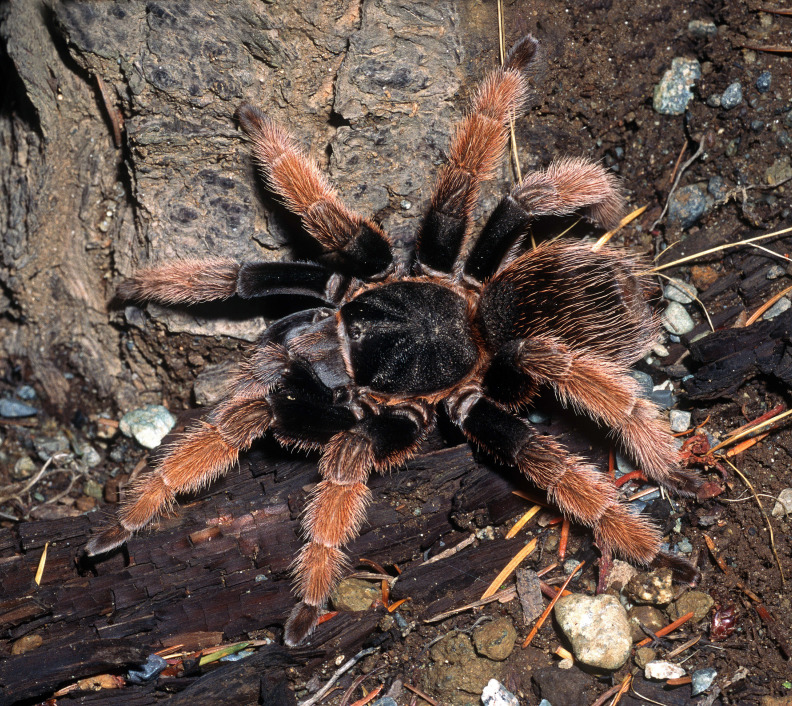
Brachypelma
klaasi (Schmidt & Krause, 1994) female near Chamela, Jalisco state, Mexico. Photo: Rick C. West.